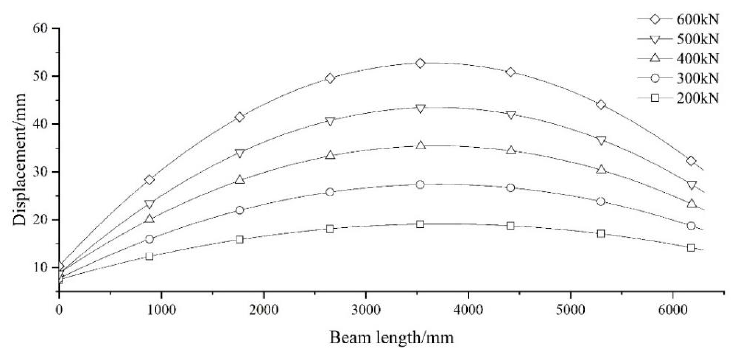
Figure 16. The load-displacement curve after fitting.